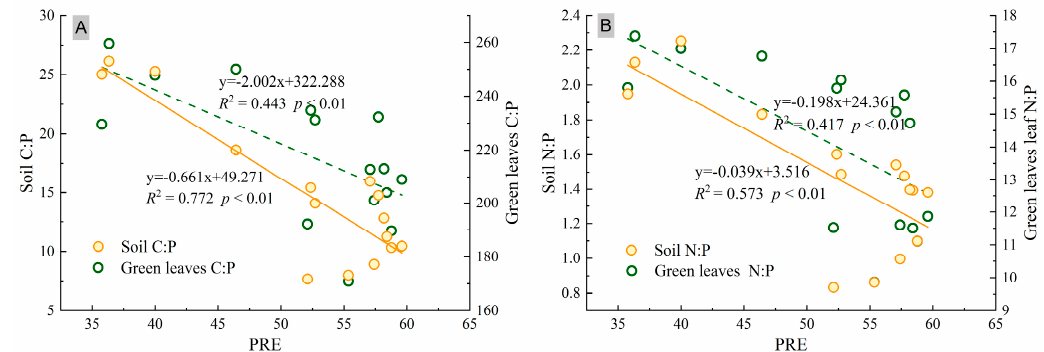
Figure 3. Correlations between PRE and soil and the C:P ( A ) and N:P ( B ) ratios of green leaves in black locust plantations from stands of different ages.